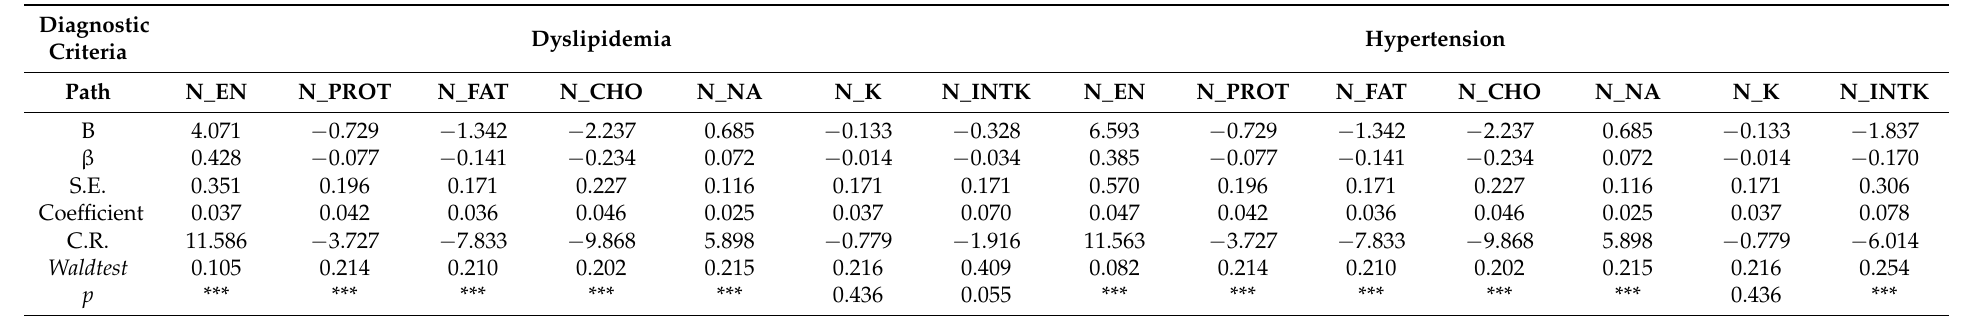
Table 7. Analysis of estimated parameters’